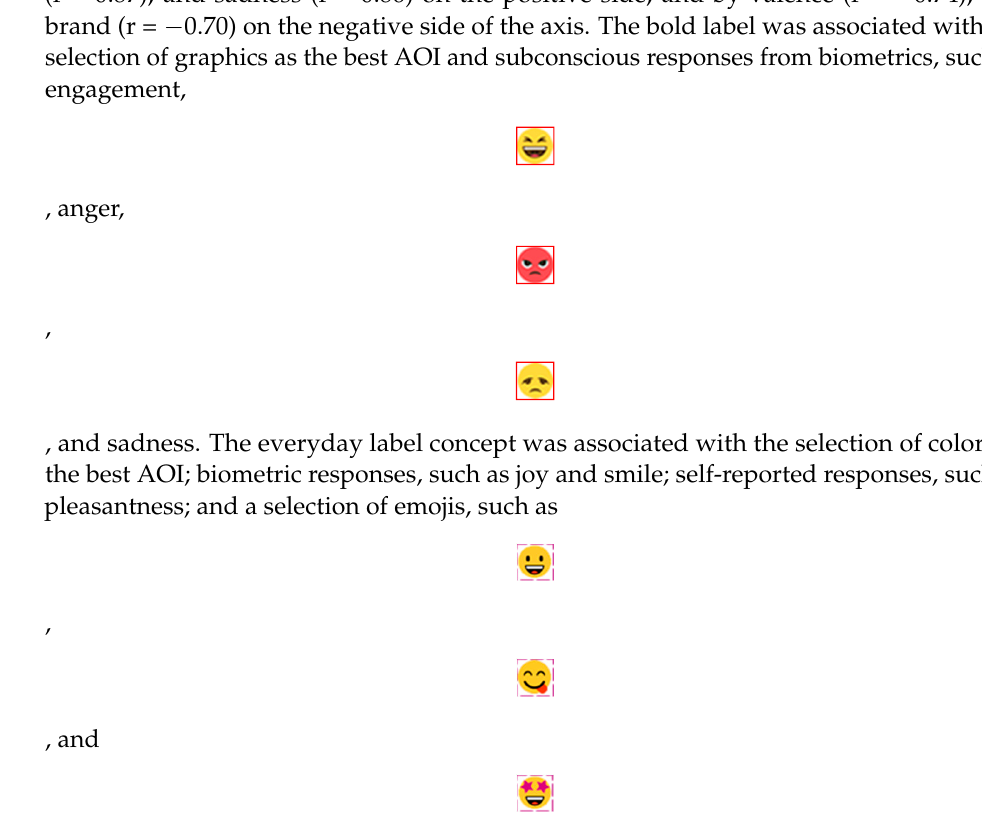
Table 2. Options provided for the check all that apply (CATA) questions for assessment of the coffee pod label